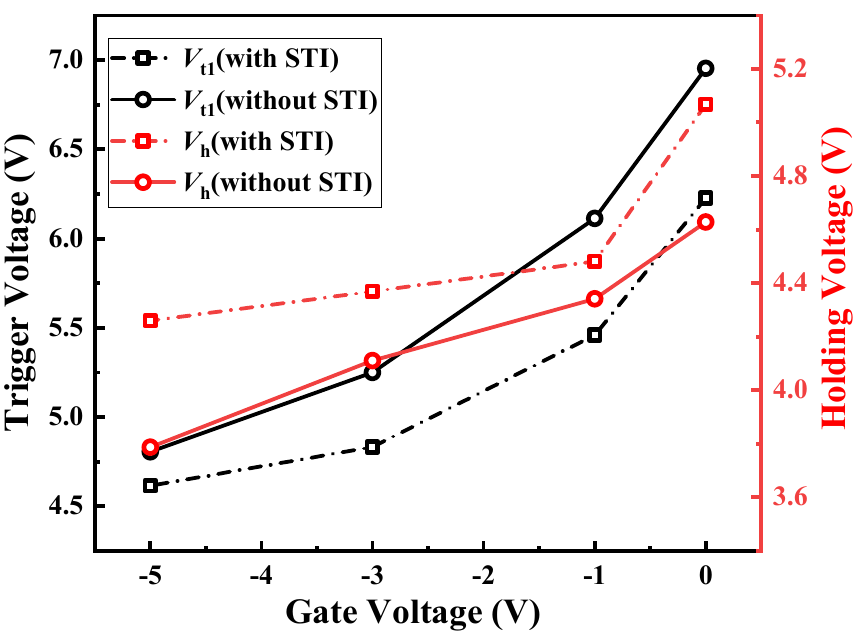
Figure 11. Trigger voltage, holding voltage for the PTBSCR (L = 0.5 μ m) versus different gate voltages.